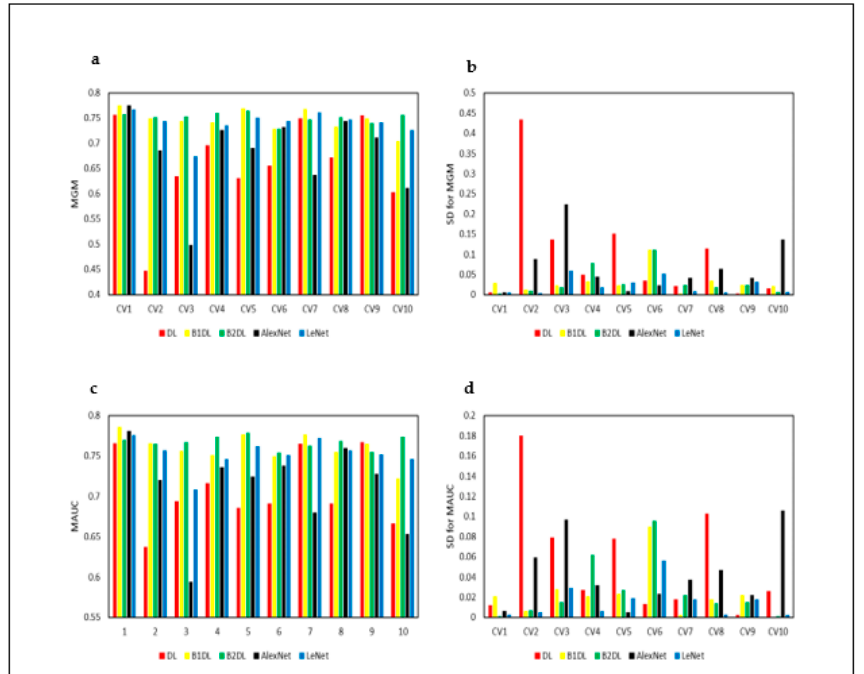
Figure 9. Performance results of all prediction algorithms, applied to test examples pertaining to in vitro bovine embryos. These results are obtained by running CV 10 times. CV i is the i th cross-validation MGM is the mean G-Mean. MAUC is the mean AUC. SD is the standard